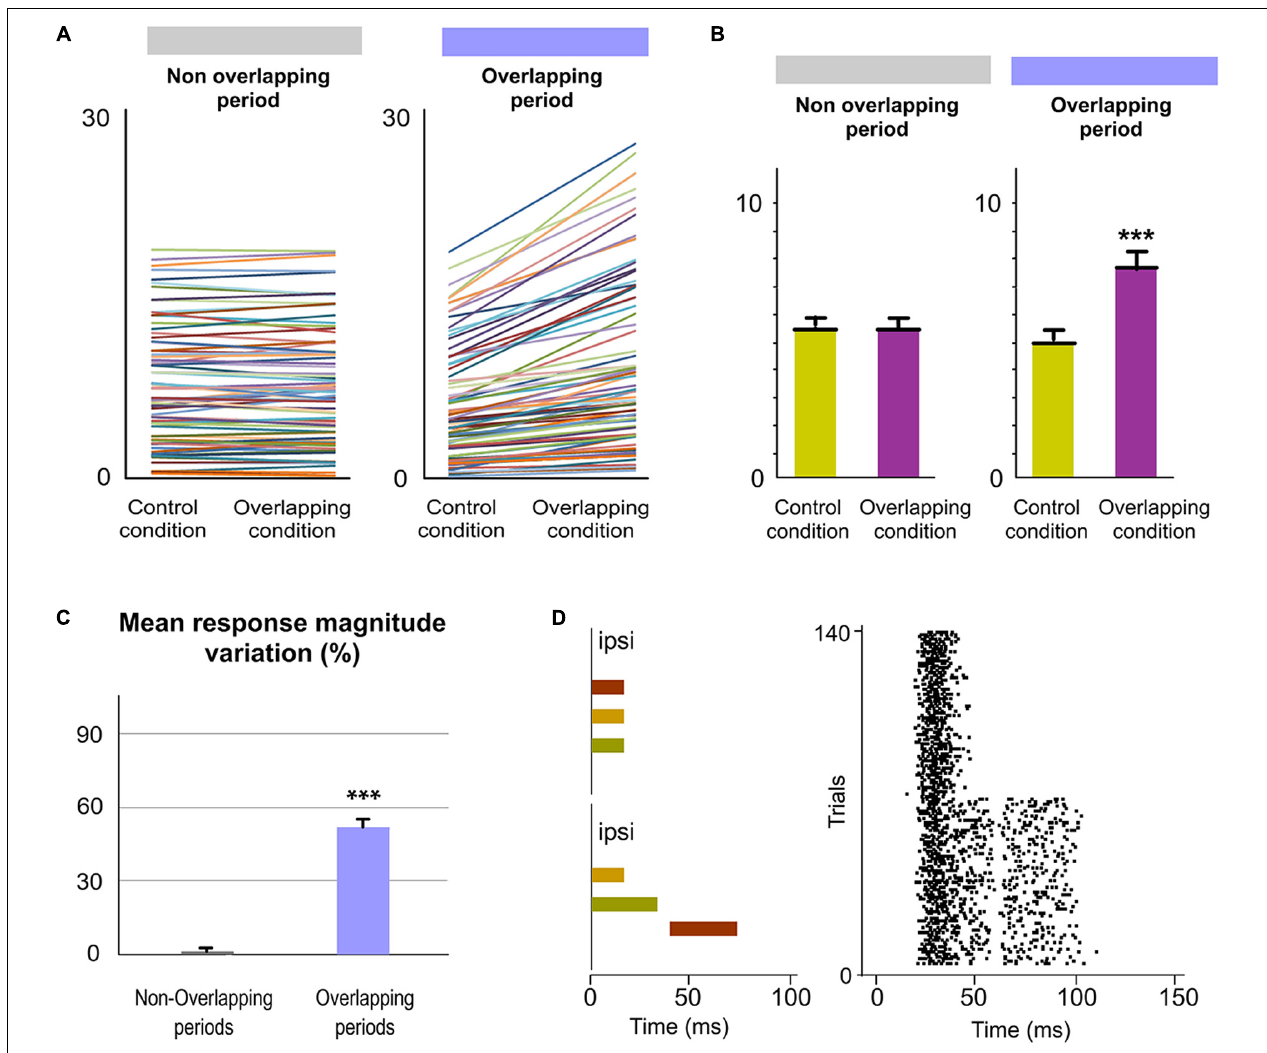
FIGURE 9 | POm integration of ipsilateral overlapping events. (A) Data showing the quantification of the facilitative integration during overlappings of ipsilaterally evoked signals. Plots comparing the spike rate of all recorded multi-units ( n = 80, depicted in different colors) during the Overlapping and Non-overlapping response periods in Control and Overlapping conditions across sensory patterns. (B) The mean firing rate was significantly increased in the Overlapping periods ( p < 0.001; Wilcoxon matched-pairs test) but not in the Non-overlapping periods where the mean magnitude of responses did not change ( p = 0.97; Wilcoxon matched-pairs test). (C) Mean response magnitude variation (%) between Control and Overlapping conditions in Non-Overlapping and Overlapping periods ( p < 0.001, Wilcoxon matched-pairs test). (D) Raster plots of representative POm responses to two different overlapping protocols of multiwhisker ipsilateral stimulation. An increase in POm response magnitude can be appreciated as more inputs were temporally overlapped in these protocols. Note that the general temporal structure of the sensory pattern, the temporal position of its components (depicted in different colors) and their corresponding overlappings are reflected in the structure of POm response. *** P <